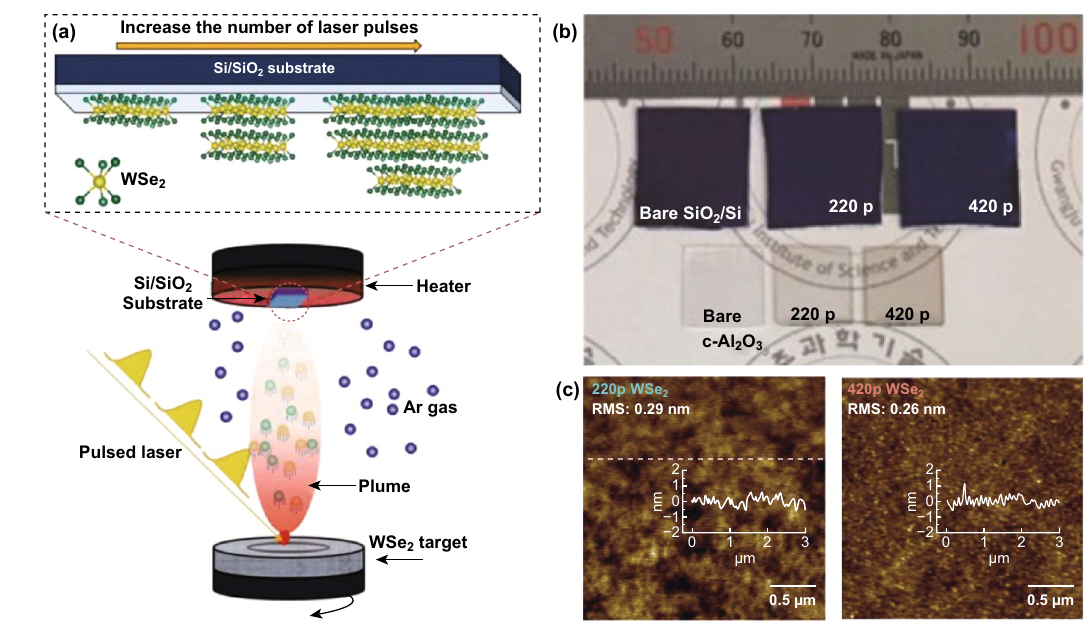
Fig. 3 Large-area synthesised TMDCs by PLD. a Schematic illustration of deposition of WSe 2 by PLD. b Optical images of as–grown WSe 2 thin films on SiO 2 /Si and c Al 2 O 3 substrates. c Typical AFM images with a height profile of the 220 p WSe 2 and 420 p WSe 2 . Adapted with per- mission from Ref. [33]. Copyright 2018,